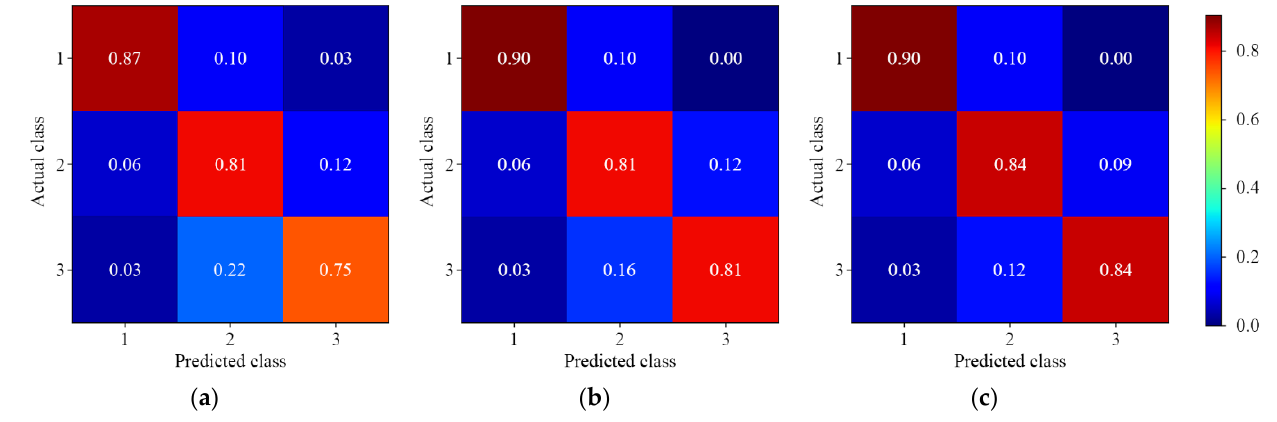
Figure 8. The normalized confusion matrix for three-level discrimination of lambda-cyhalothrin residues. ( a ) Single-depth 1D-CNN; ( b ) Symmetric multiscale 1D-CNN; ( c ) Asymmetric multiscale 1D-CNN.